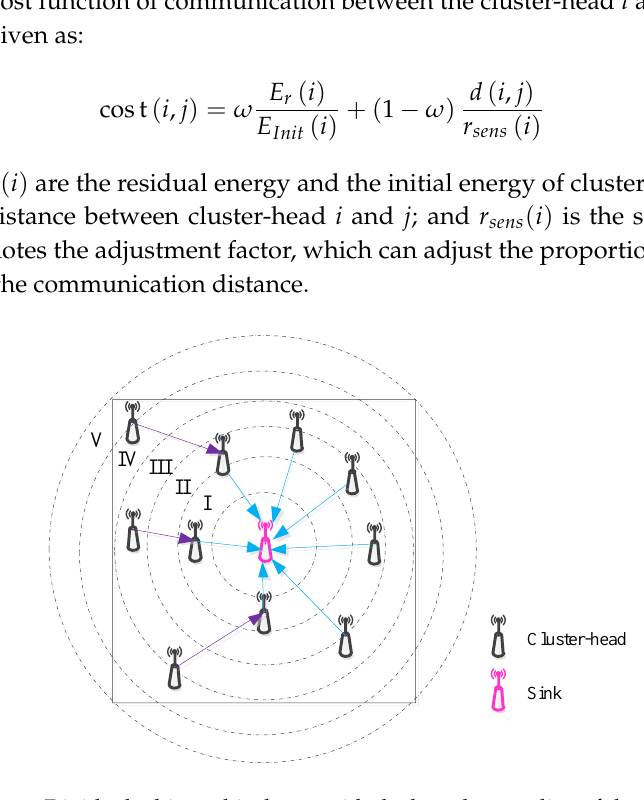
Figure 2. Divide the hierarchical area with the broadcast radius of the sink. Algorithm 3 Inter-cluster topology